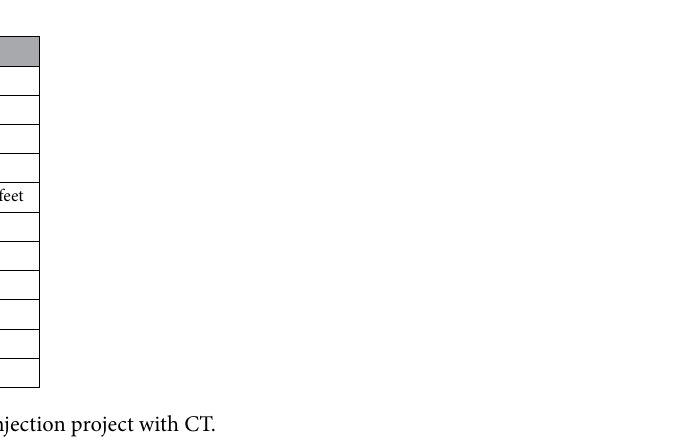
Table 12. Information on water injection project with